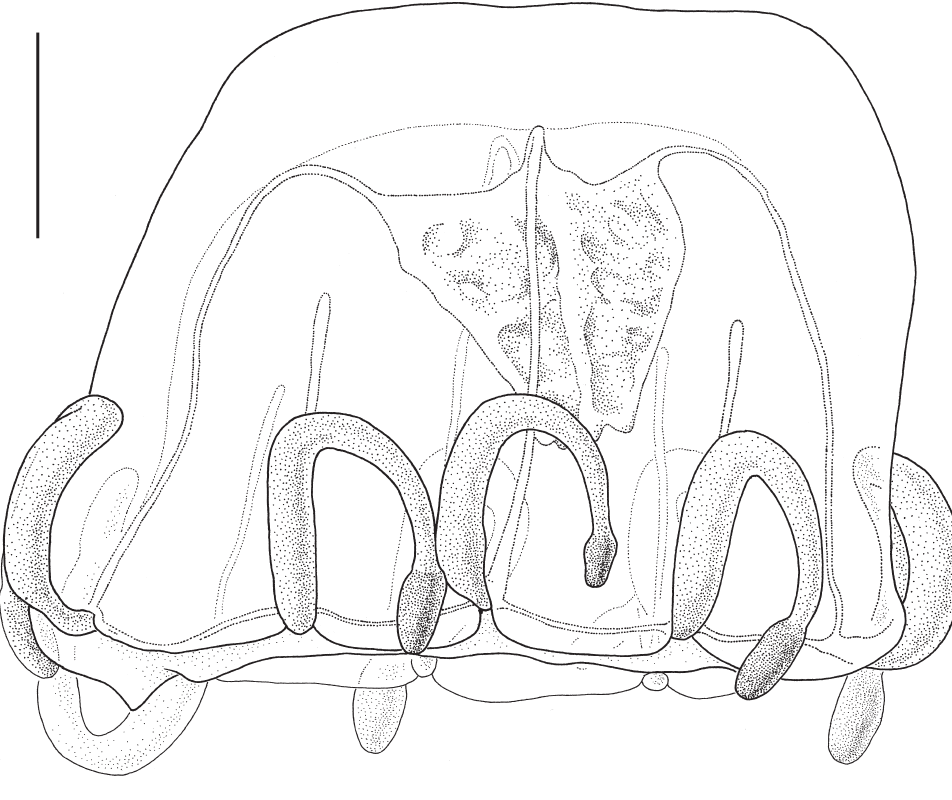
Material: Lacaze-Duthier canyon, 500m depth, December 1994, 1